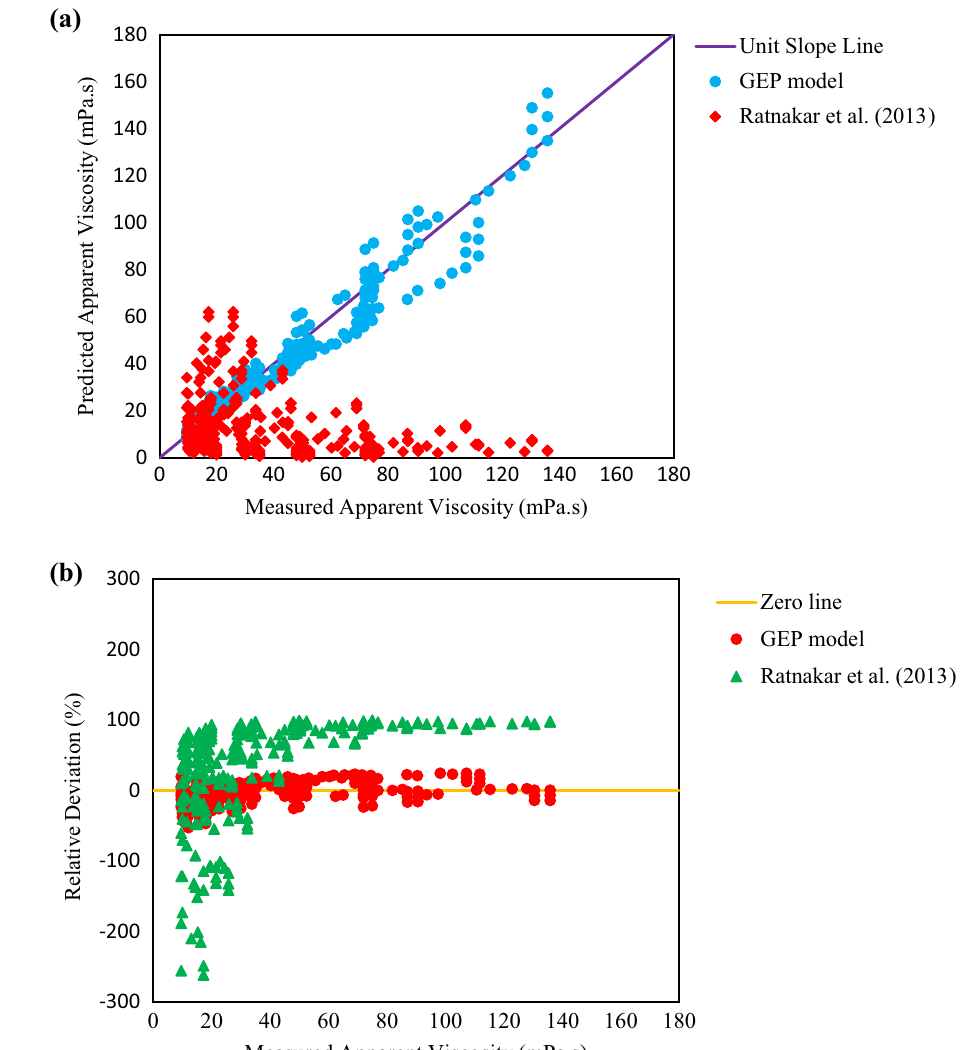
Fig. 10 A comparison between the suggested GEP model and a traditional published correla- tion [36] using a cross plot and b the relative deviation